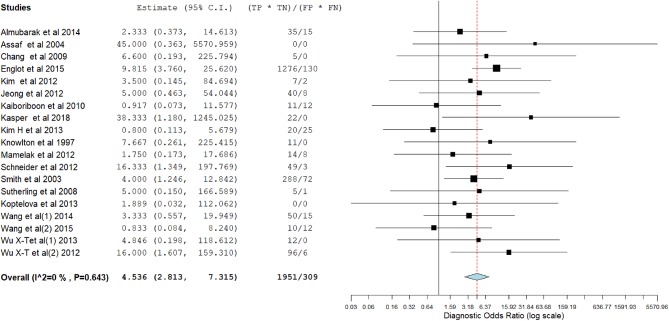
Forest plot showing diagnostic odds ratio of the II-MSI studies (individual studies: size of the squares are proportional to weights used in meta-analysis; the summary measure: center line of the diamond; associated 95% confidence intervals: lateral tips of the squares and the diamond).